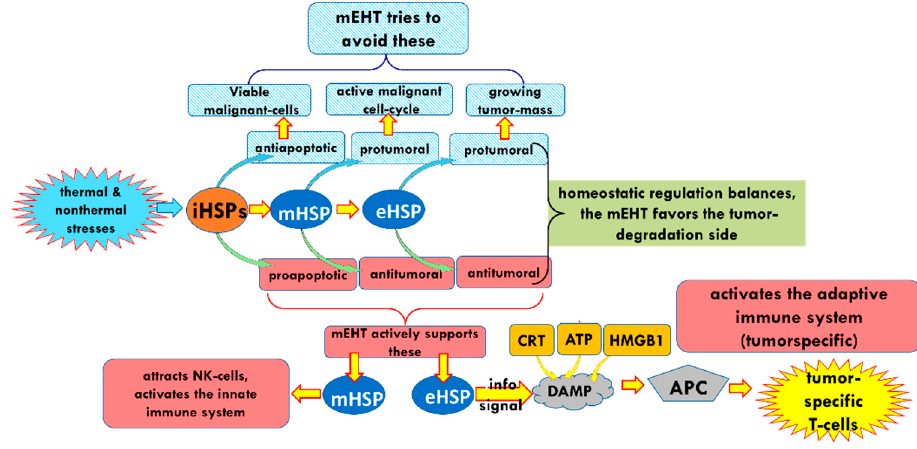
Figure 21. Summary of the role of HSP in the relevant processes.